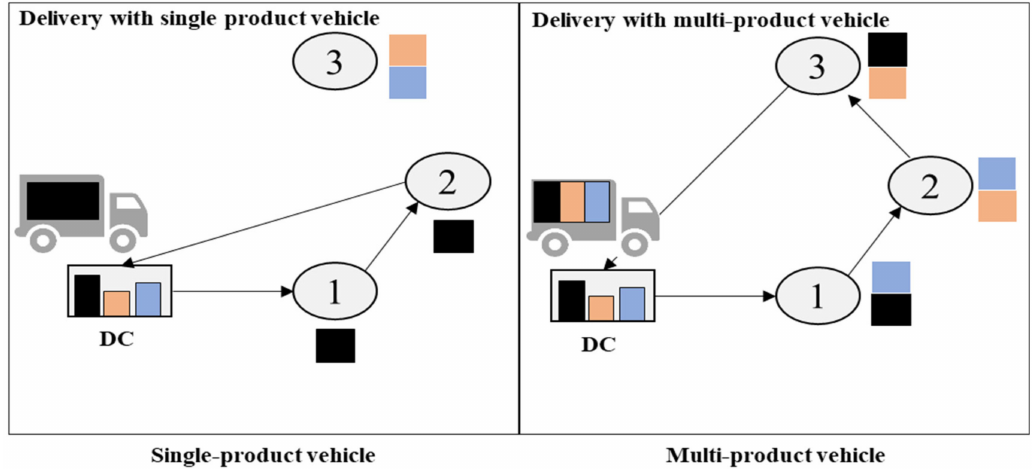
Figure 2. The delivery route for single-product vehicle and multi-product